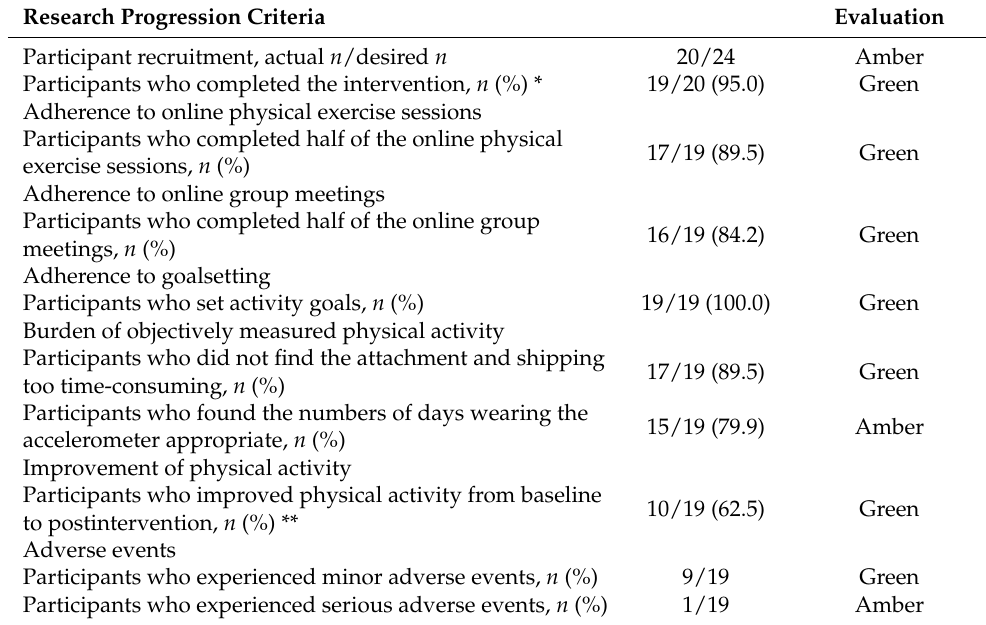
Table 3. Research progression criteria results to evaluate whether to progress with a definitive RCT.